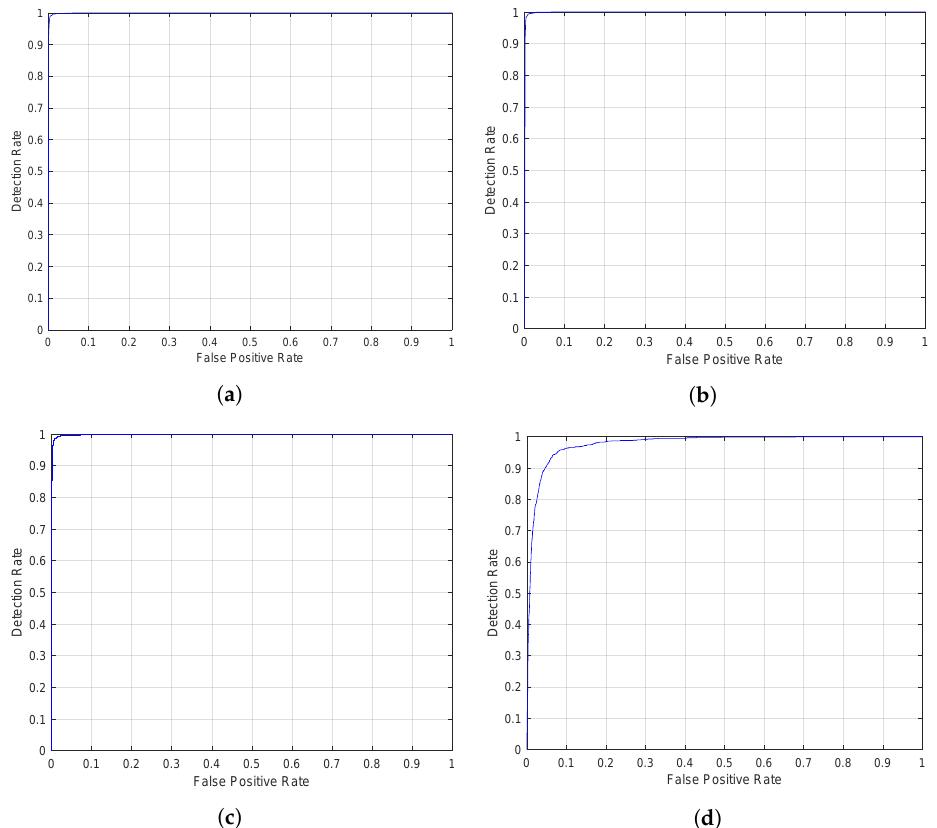
Figure 9. ROC Curves of the few pre-trained models using 5-Fold cross validation ( a ) InceptionRes- NetV2 ( b ) Xception ( c ) ResNet50 ( d ) AlexNet. Table 12. Performance comparison of existing works with proposed